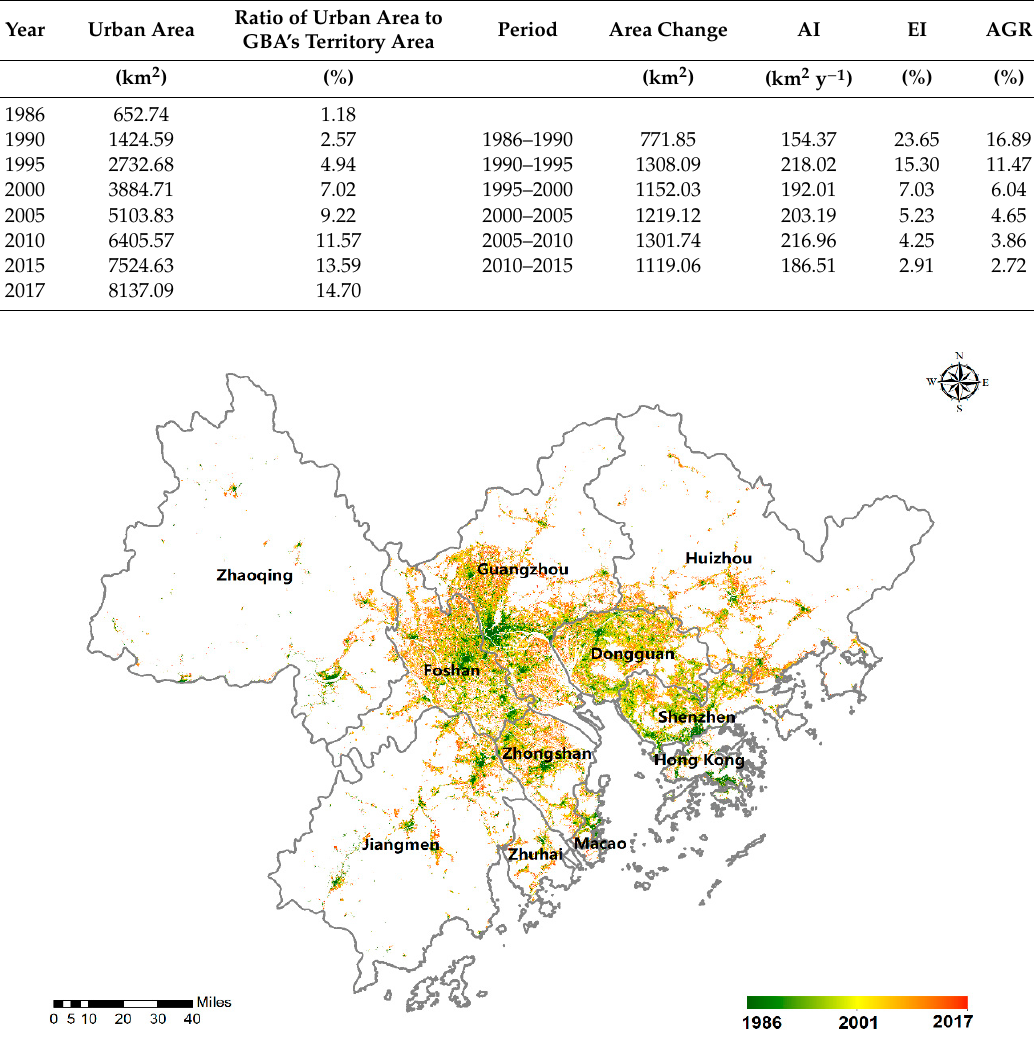
Figure 2. The annual urban expansion process in the GBA during 1986-2017.